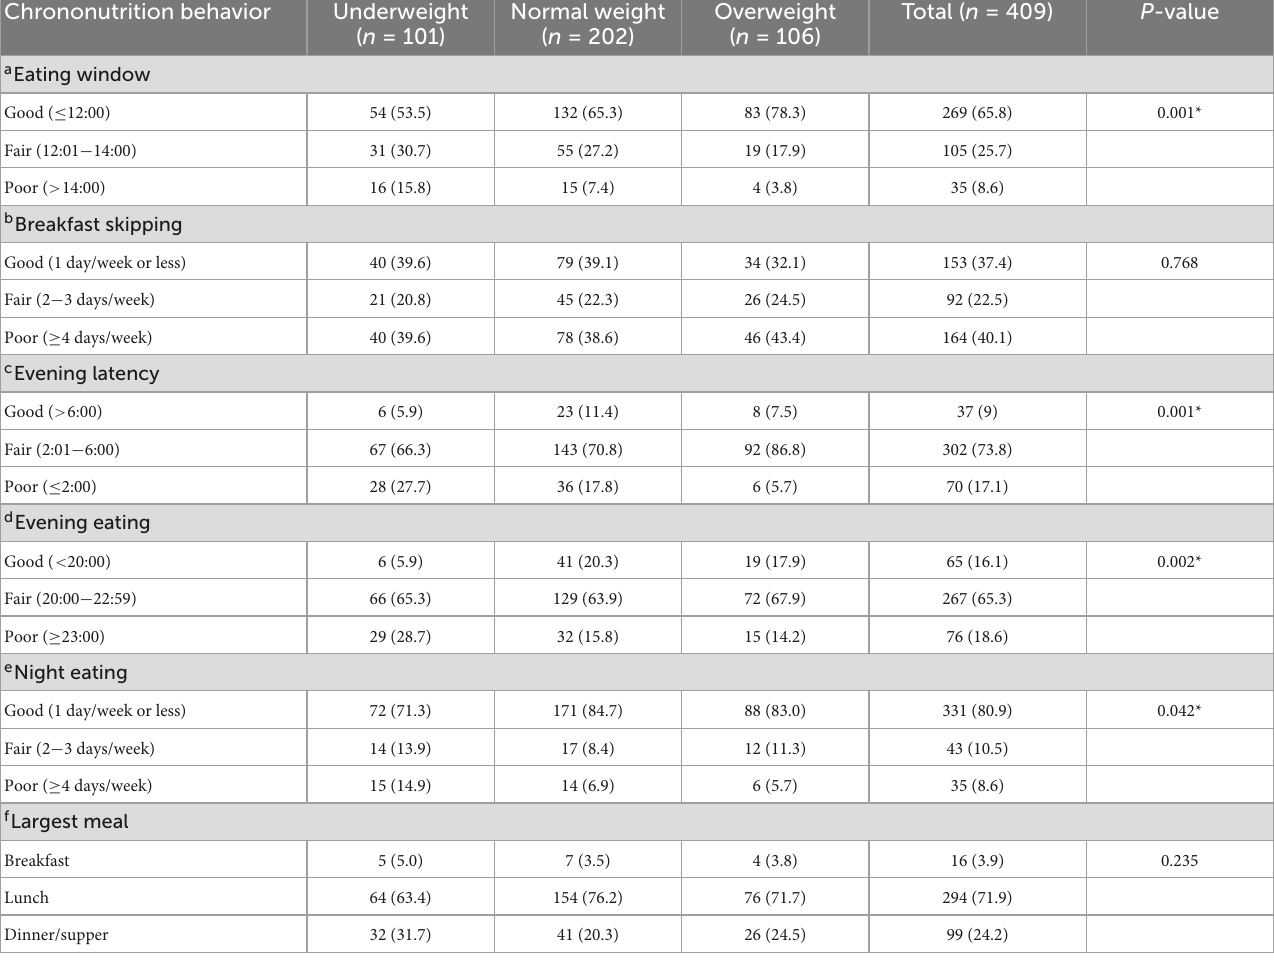
TABLE 4 Association between the scoring of chrononutrition behavior with BMI. Chrononutrition behavior Underweight